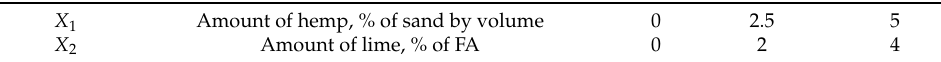
Table 7. Variables in the experimental